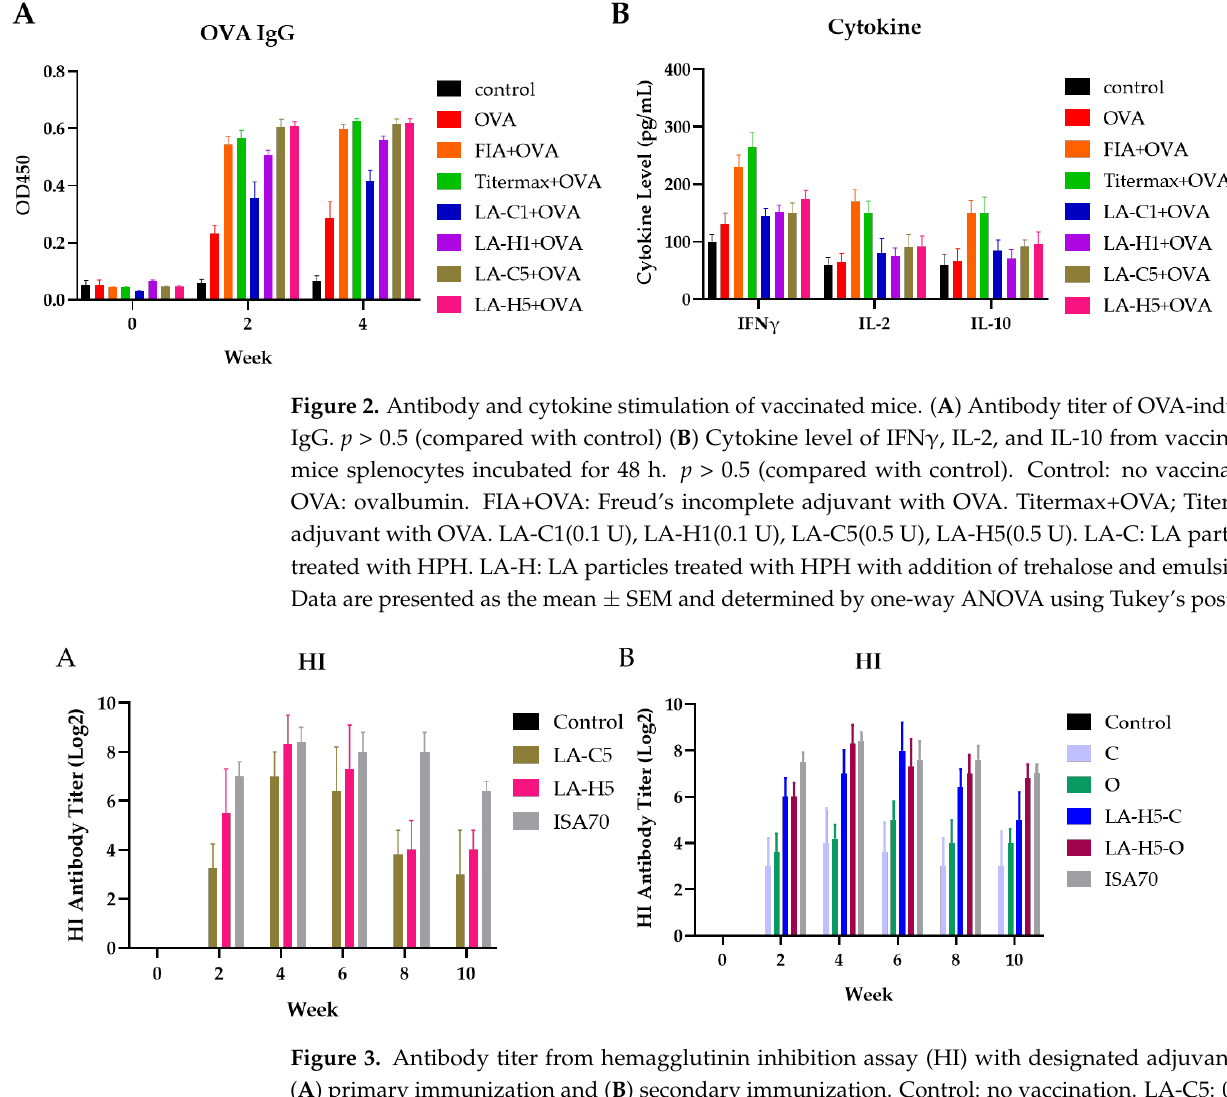
Figure 3. Antibody titer from hemagglutinin inhibition assay (HI) with designated adjuvants of ( A ) primary immunization and ( B ) secondary immunization. Control: no vaccination. LA-C5: 0.5 U LA particles. LA-H5: 0.5 U LA particles with trehalose and emulsifiers. ISA70: Montanide ISA70 W/O adjuvant. LA-H5: *, ISA70: ** (compared with control) in Figure 3A; LA-H5-C: **, LA-H5-O: **, ISA70: ** (compared with control) in Figure 3B. *: p <0.05, **: p <0.01. Data are presented as the mean ± SEM and determined by one- way ANOVA using Tukey’s posttest.